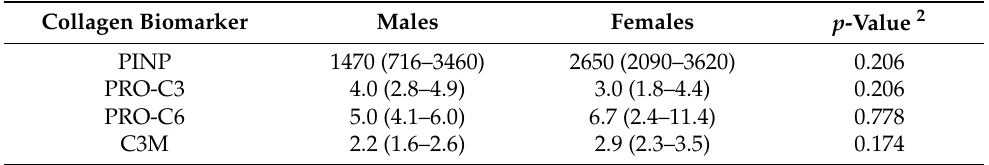
Table 2. Effect of sex on cumulative release of PINP, PRO-C3, PRO-C6, and C3M biomarkers by colorectal fibroblasts (CoReFs) into the media over 8 days of culture shown as ng/well. 1. Collagen Biomarker Males Females p -Value 2 PINP